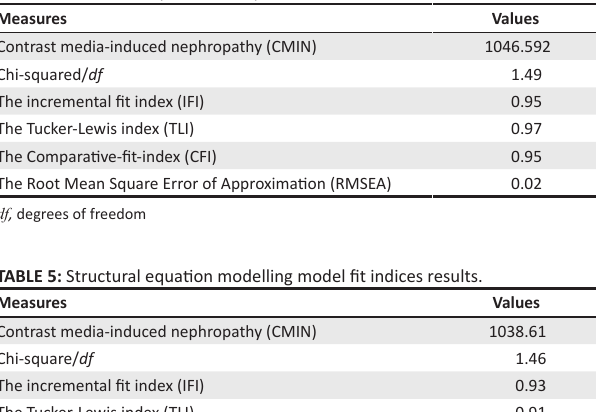
TABLE 4: Confirmatory factor analysis model fit indices results.